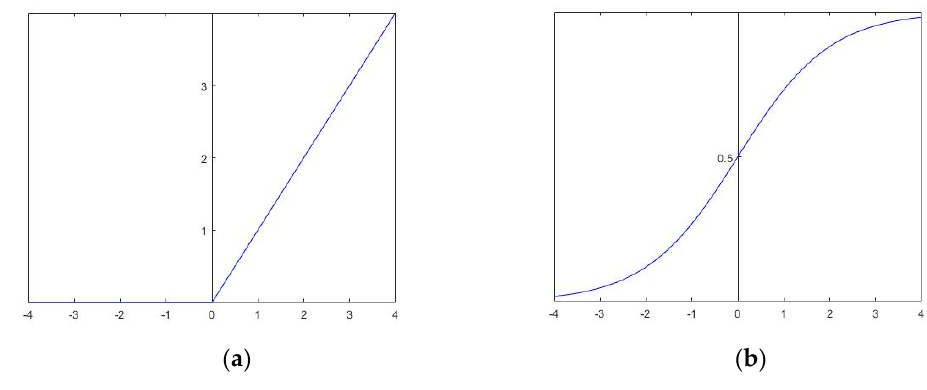
Figure 2. Activation function; ( a ) ReLU ( b ) Sigmoid.